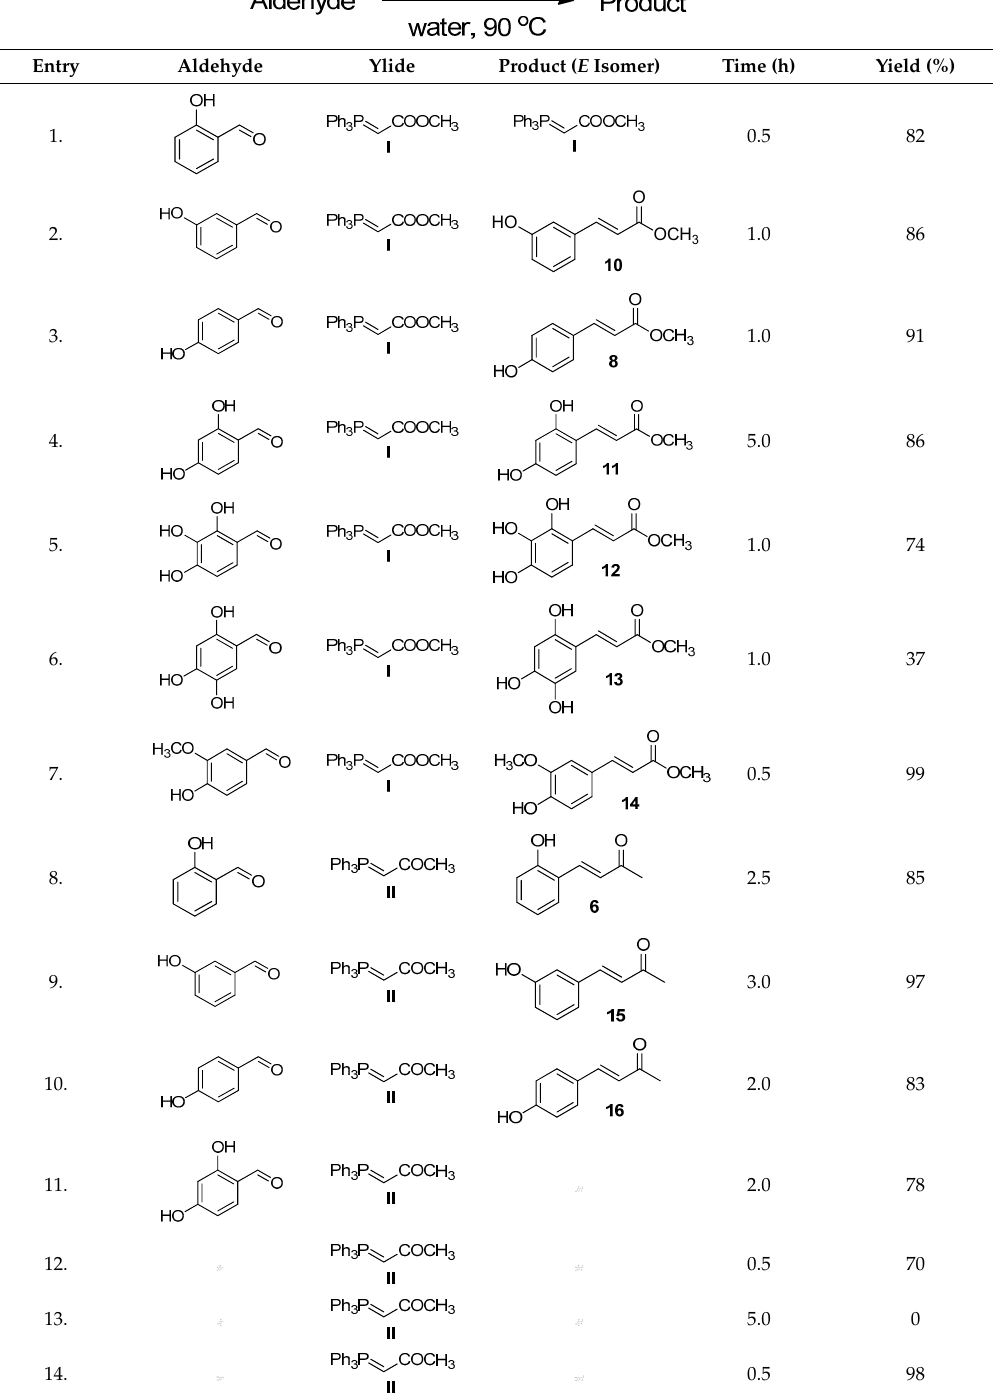
Table 1. The Horner–Wadsworth–Emmons (HWE) reaction of different aromatic aldehydes in water.